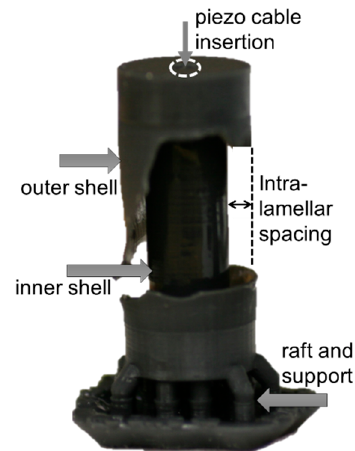
Figure 3. Photograph of the printed artificial Pacinian corpuscle 2-layer design. The outer layer was removed to show the first fluid encapsulation volume.